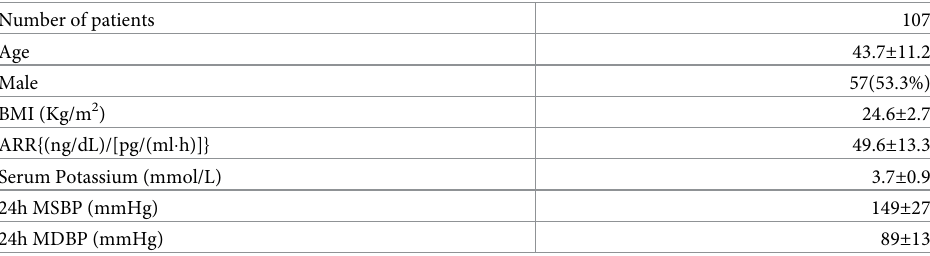
BMI: Body Mass Index, ARR: aldosterone-to-renin ratio, MSBP: Mean Systolic Blood Pressure, MDBP: Mean Diastolic Blood